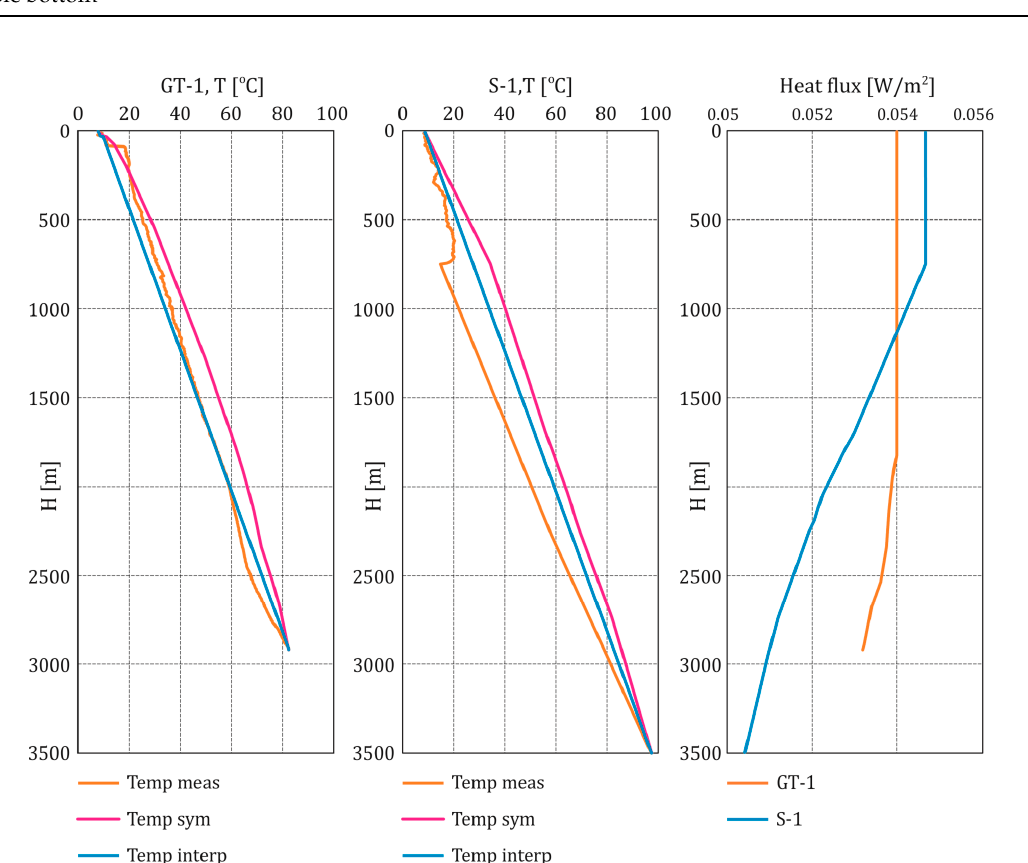
Figure 6. Results of temperature and heat flux modelling in GT-1 and S-1boreholes; Temp sym—result of modelling, Temp meas—measured temperature, Temp interp—interpolated result of temperature